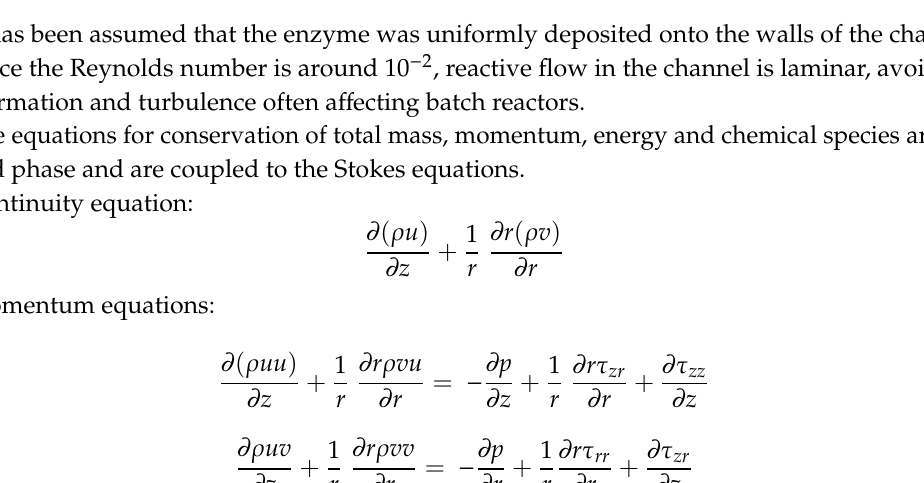
Figure 1. Scheme of a cordierite channel.